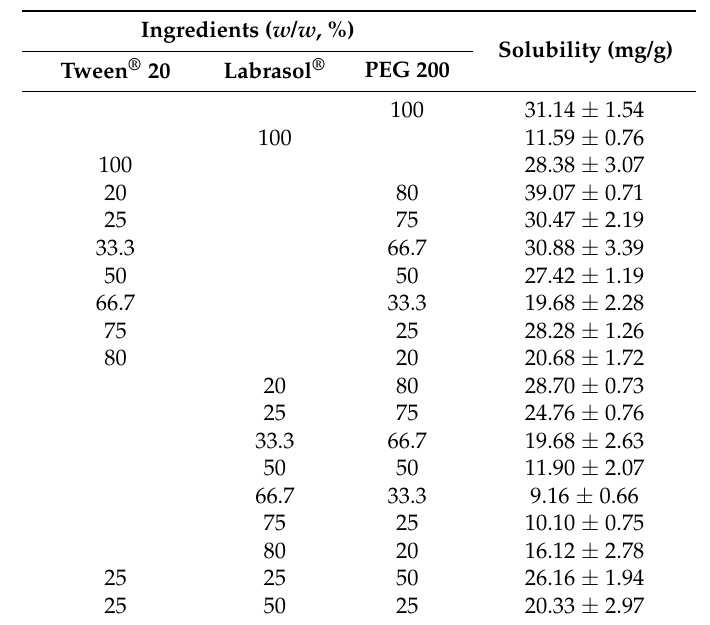
Table 2. The solubilities of raloxifene hydrochloride at various surfactant/cosurfactant ratios (Tween ® 20/PEG 200 and Labrasol ® /PEG 200 ratios) at 40 ◦ C. All data are means ± SDs ( n = 3).